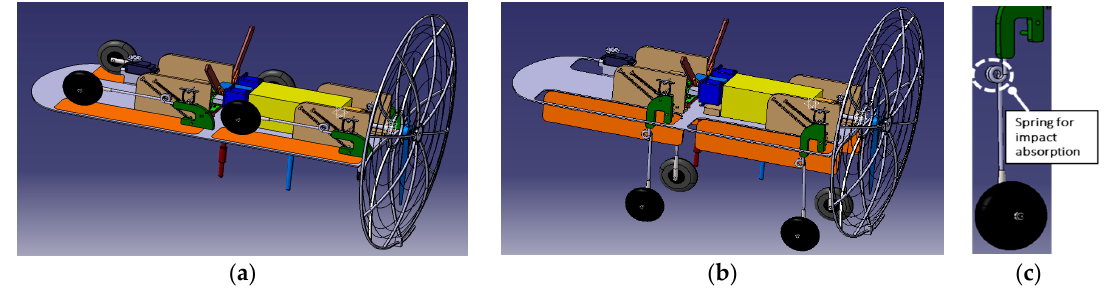
Figure 2. Fuselage open view: retracted ( a ) deployed arms ( b ); arm detail ( c ).